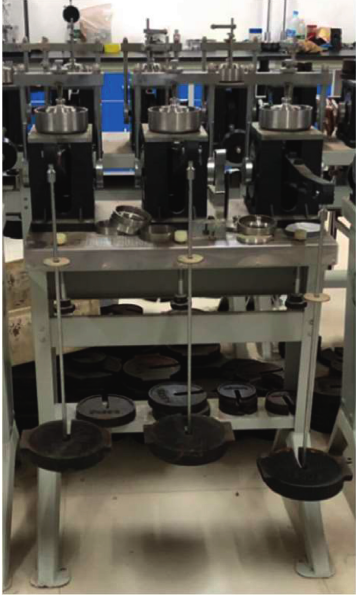
Figure 3: Consolidation test